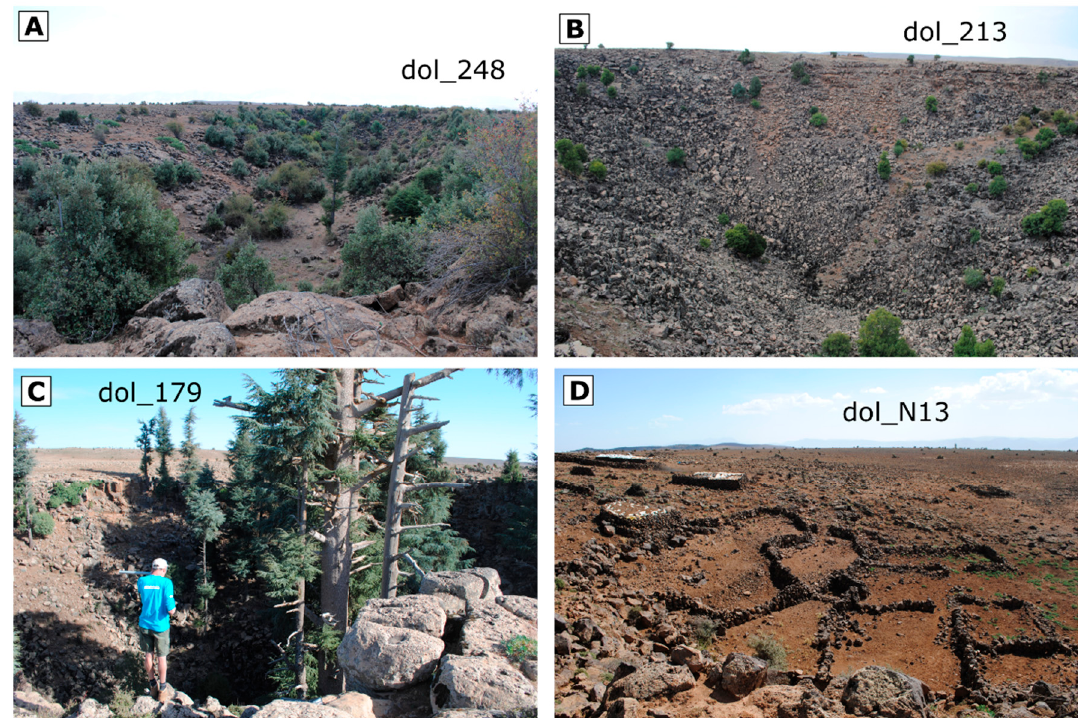
Figure 10. Examples of typical dolines that produced the highest depth differences. ( A ) mixed geometry doline with dense vegetation and boulders; ( B ) funnel-shaped deep doline with blocks and boulders on the bottom; ( C ) funnel-shaped doline with high trees covering the bottom; ( D ) shallow flat-shaped doline with dry stone walls at the bottom and near the knick- points.